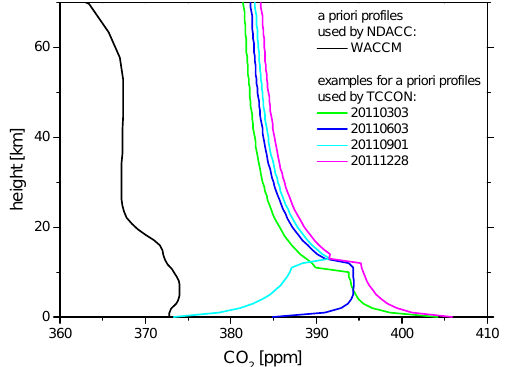
Figure 4. Column-averaging kernel for Karlsruhe (NDACC; 04 June 2010, 07:36UT, solar elevation 38.15 ◦ ) and Lamont (TCCON) Fig. 4. Column averaging kernel for Karlsruhe (NDACC)(04 June for the same solar elevation. 2010, 7.36UT, solar elevation 38.15 ◦ ) and Lamont (TCCON) for Fig. 4. Column averaging kernel for Karlsruhe (NDACC)(04 June the same solar elevation. 2010, 7.36 UT, solar elevation 38.15 ◦ ) and Lamont (TCCON) for Table 2. Uncertainty sources used for our error estimation. The the same solar elevation. second column gives the assumed uncertainty value and the third Table 2. Uncertainty sources used for our error estimation. The column the assumed partitioning between statistical and systematic second column gives the assumed uncertainty value and the third Table 2. Uncertainty sources used for our error estimation. The column the assumed partitioning between statistical and systematic second column gives the assumed uncertainty value and the third sources. column the assumed partitioning between statistical and systematic sources. Stat./Syst. Error source Uncertainty Stat./Syst.